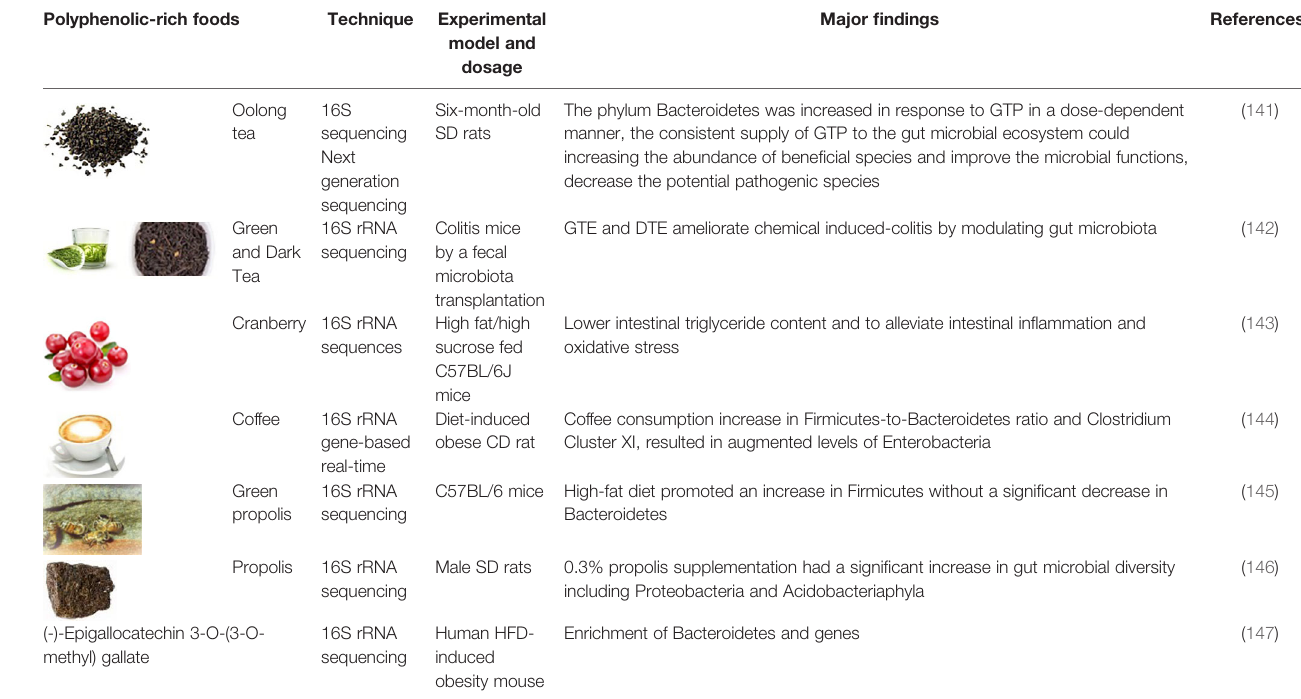
TABLE 2-1 | Genomics in understanding the GI protective effects by polyphenols and polyphenolic-rich foods. Polyphenolic-rich foods